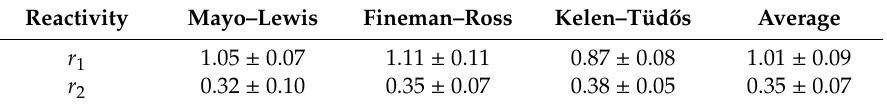
Figure 11. Kelen–Tüd˝os plot indicating variation of η vs. µ for copolymerization of EUGMA with MMA. Table 4. Reactivity ratios of the copolymerization of EUGMA with